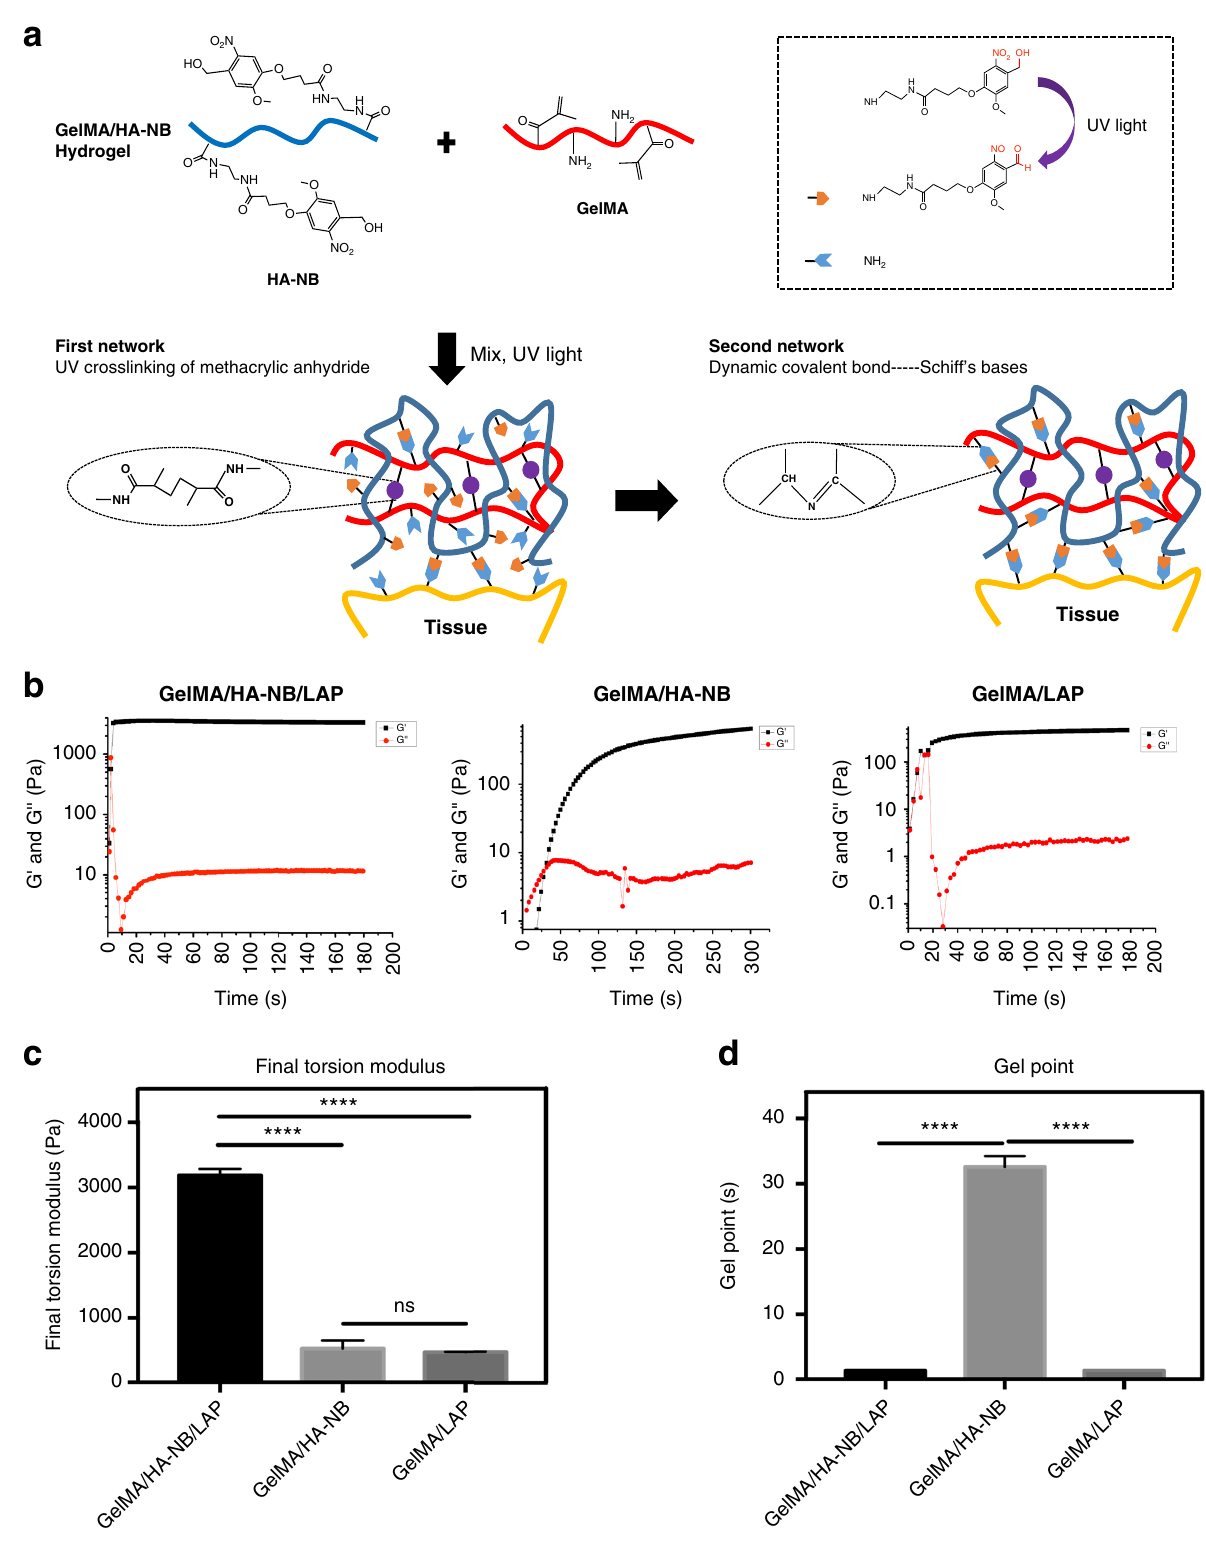
Fig. 1 Chemical structure and mechanical properties of the hydrogels. a Constituent chemical structures and a schematic diagram illustrating the formation of the photo-triggered imine-crosslinked matrix hydrogel. b To monitor the gelling process, a dynamic time-sweep rheological analysis was carried out with an in situ photo-rheometer (HAAKE Mars III, light, Omnicure S2000 365 nm: 30 mWcm − 2 ) showing the formation kinetics for GelMA/HA-NB/LAP, GelMA/HA-NB, and GelMA/LAP hydrogels. c The fi nal torsion modulus G ’ of different hydrogels. d The gel point of different hydrogels. All the gelling measurements were conducted using OmniCure S2000 (365 nm, 30 mW/cm 2 ). Exposure time: 180 s for GelMA/HA-NB/LAP and GelMA hydrogels, and 300s for GelMA/HA-NB hydrogel (error bars, mean ± SD. **** p < 0.0001; NS: no signi fi cance, one-way analysis of variance (ANOVA), Tukey ’ s post hoc test) ( n = 3 per group). Source data are available in the Source Data fi